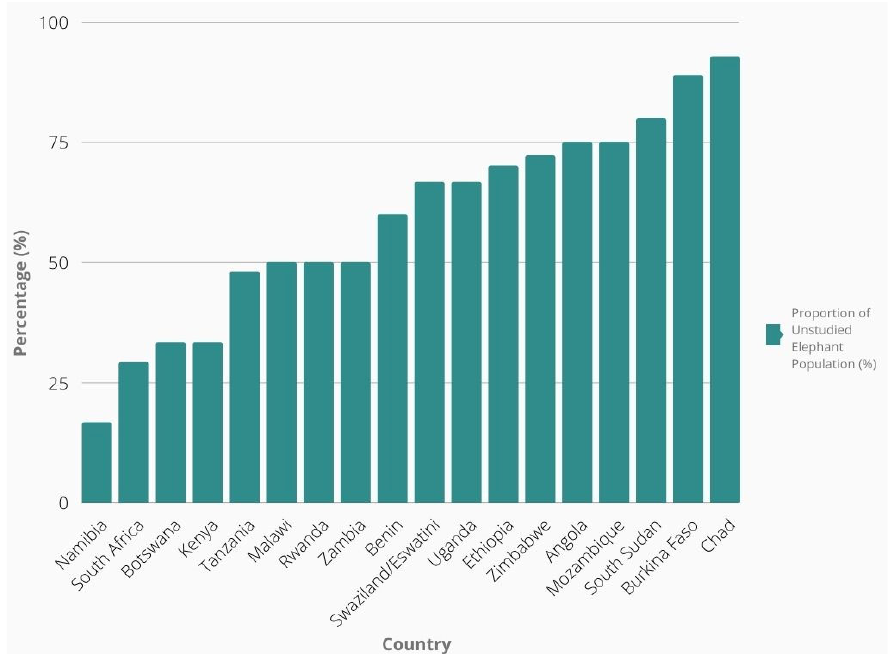
Figure 3. Percentage of PAs by country where no research on elephants has been published over the last 20